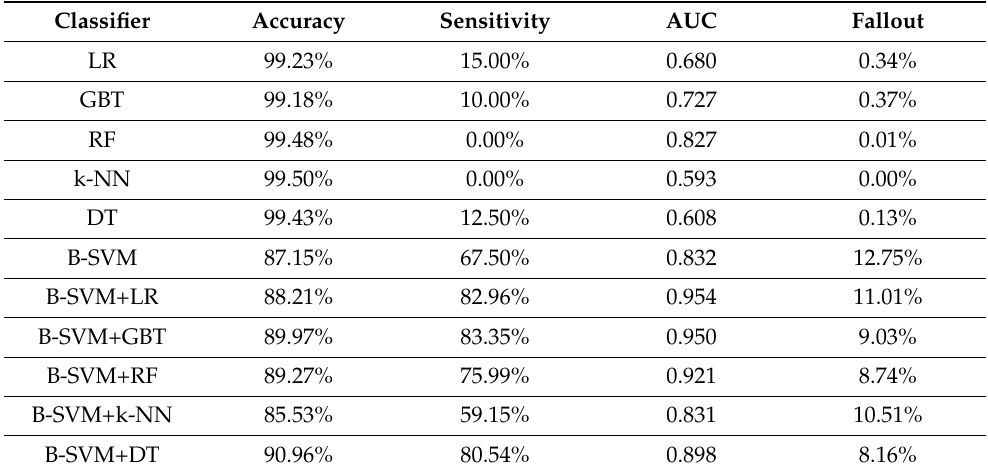
Table 4. Predictive performance of classification algorithms without and with SVM